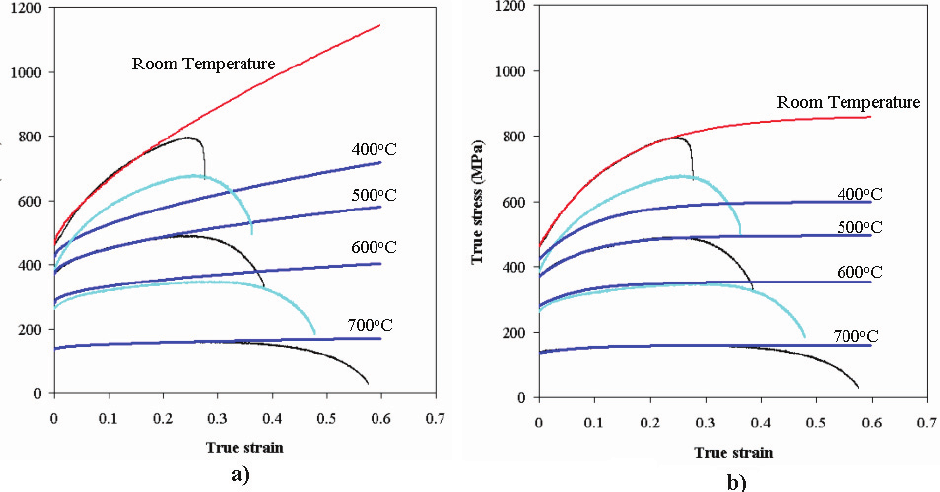
Figure 6. Prediction of modified J-C model at elevated temperatures with (a) Ludwick’s and (b) Voce’s hardening law.